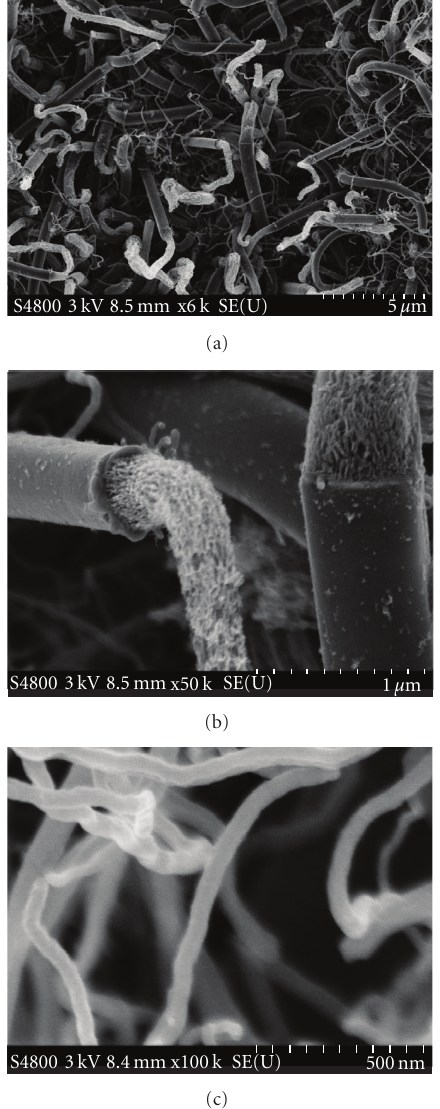
Figure 2: (a) FESEM images of CNT-CNF film, (b) CNFs, and (c) CNTs.